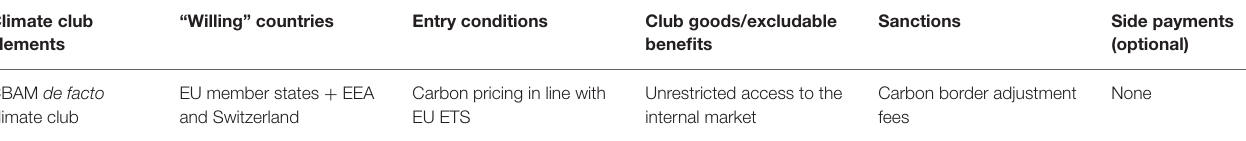
TABLE 1 | EU CBAM as a de facto climate